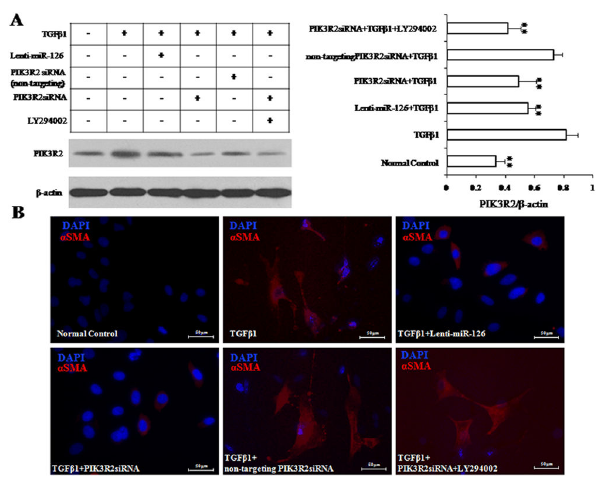
Figure 4. miR-126 inhibits EPC EndMT via targeting PIK3R2. (A) PIK3R2 expression was down-regulated by PIK3R2siRNA. (B) After the pre-treatment with PIK3R2siRNA, EPCs were treated TGFβ1 (5 ng/mL) for 7 days to induce EndMT. The αSMA expressions were detected by using immunofluorescence staining (Bar=50 μM; Blue for DAPI; Red for αSMA). ** represents P < 0.01 with an LSD t-test. EndMT by PIK3R2 knockdown on TGFβ1 treated EPC (Figure 4B). In other words, in th presence of PIK3R2 knockdown,